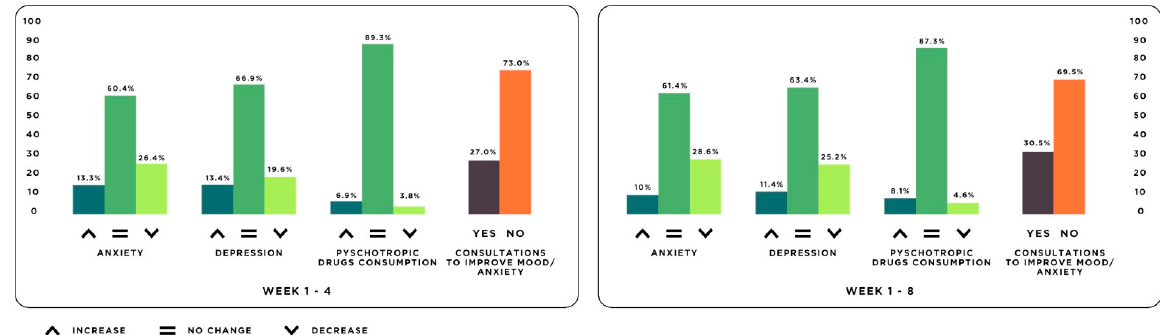
Figure 2. Proportion of individuals who experienced changes in anxiety, depression, and the consumption of psychotropic drugs and proportion of people who consulted to improve their mood or anxiety.